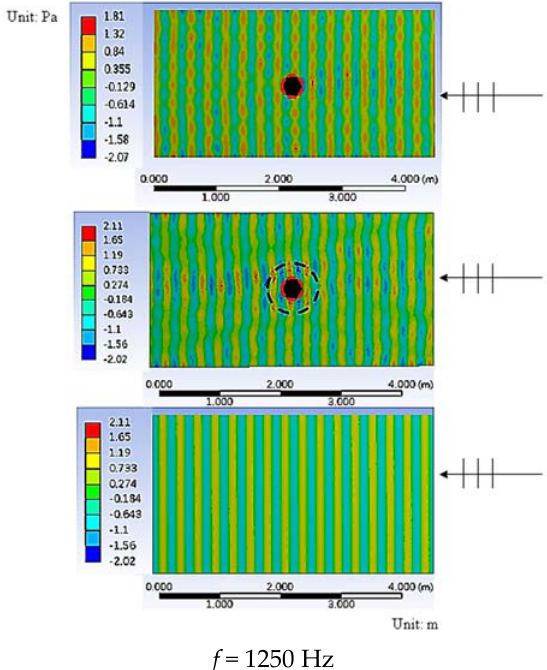
Figure 14. The wave field of the uncloaked object (upper plot), the cloaked object (middle plot), and free field at 1250 Hz. Plane waves with a specific frequency propagate from right to left. The dotted lines indicate the geometry of the cloaked object and cloak shell.